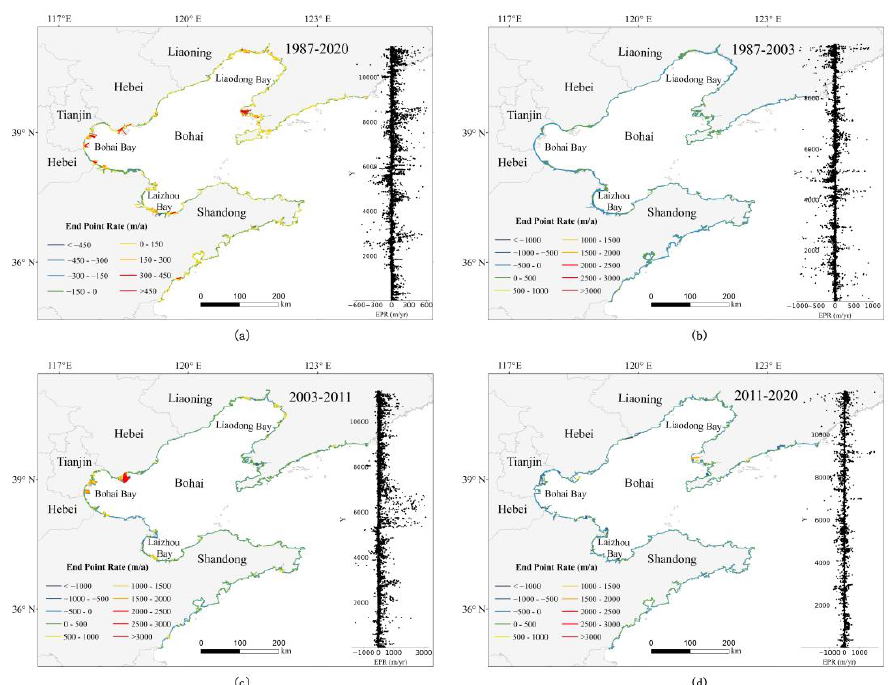
Figure 4. ( a ) Distribution of changes in coastline morphology in the circum-Bohai coastal zone during 1987–2020; ( b ) distribution of changes in coastline morphology in the circum-Bohai coastal zone during 1987 – 2003; ( c ) distribution of changes in coastline morphology in the circum-Bohai coastal zone during 2003 – 2011; ( d ) distribution of changes in coastline morphology in the circum-Bohai coastal zone during 2011 – 2020.